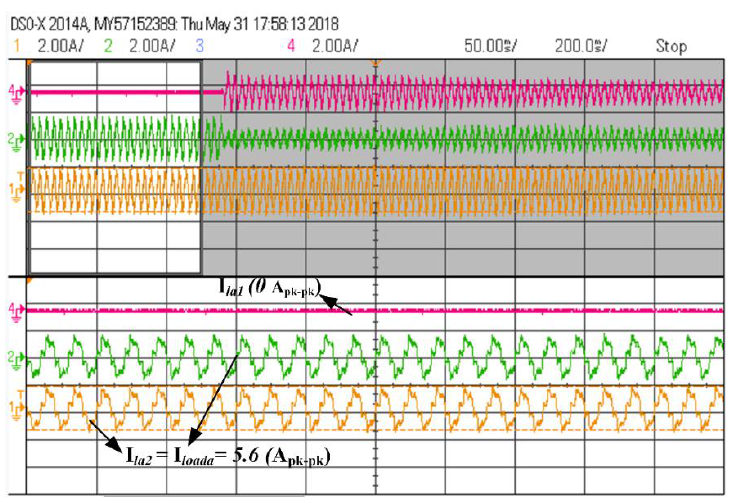
Figure 29. Current sharing when one of the inverters is in off state.